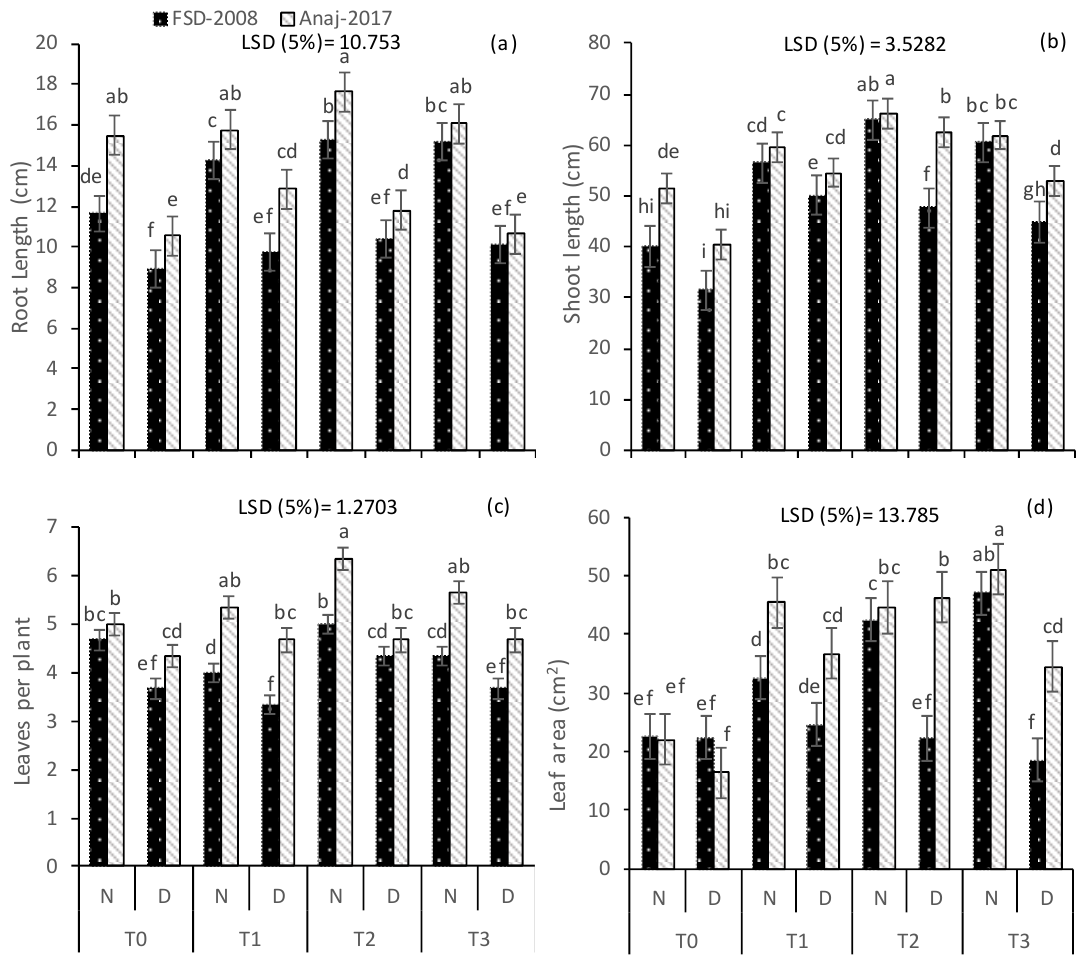
Figure 1. Effects of laser seed priming on ( a ) root length, ( b ) shoot length, ( c ) number of leaves per plant and ( d ) leaf area in wheat under drought stress. Legend: N = Control (100% field capacity), D = Drought (50% field capacity), T0 = Unprimed control, T1 = 1 min laser priming, T2 = 2 min laser priming and T3 = 5 min laser priming. Means sharing same lowercase letters on bars are statistically non−significant at P ≤ 0.05%)